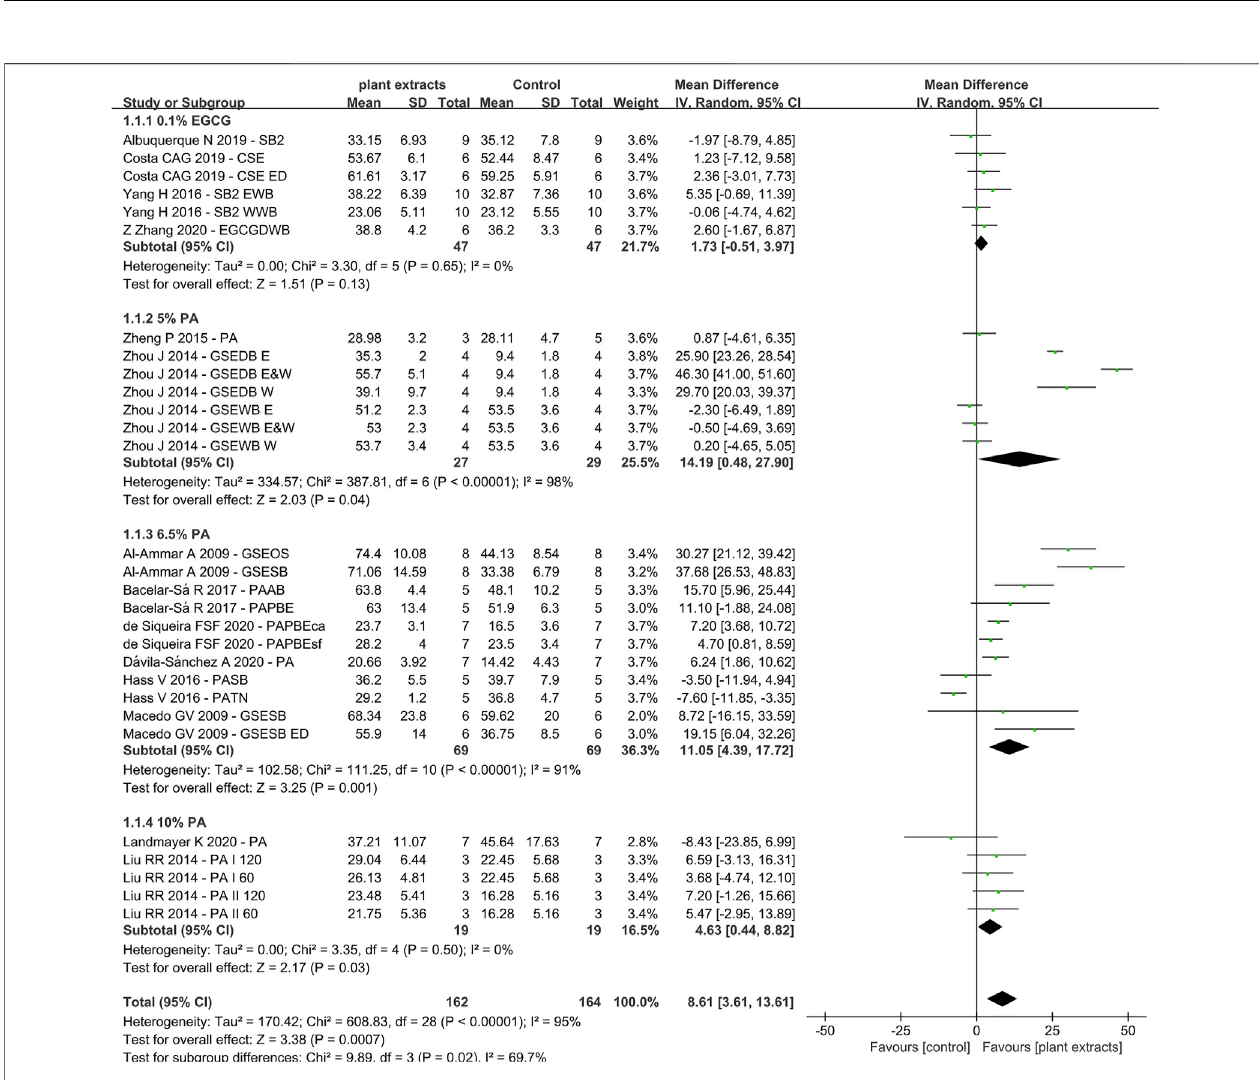
FIGURE 3 | Forest Plot — plant extract primers: etch-and-rinse immediate bond strength.